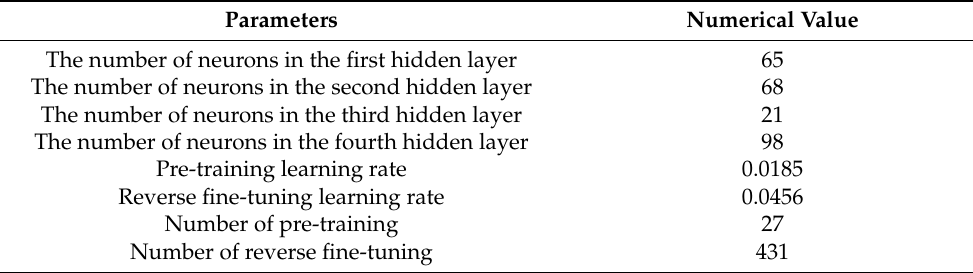
Table 3. IPSO optimization results.